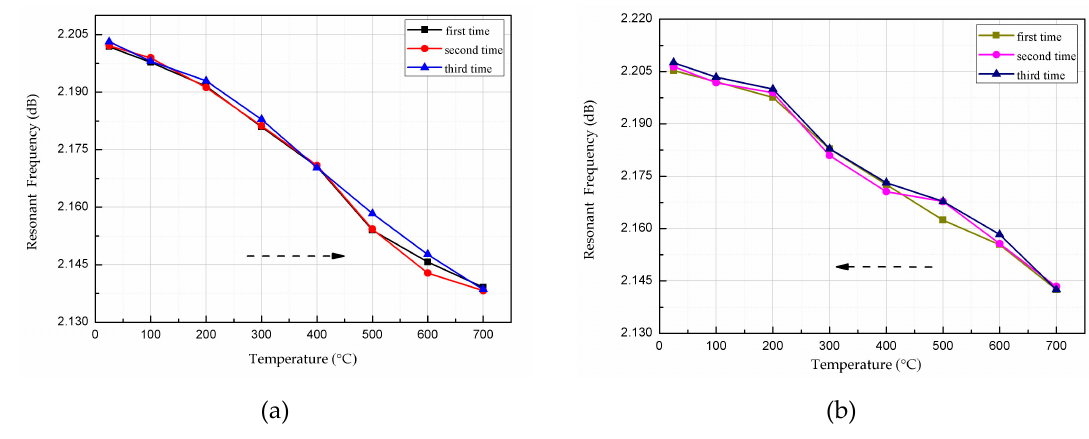
Figure 14. Sensor repeatability test curve: ( a ) heating process; ( b ) cooling process.